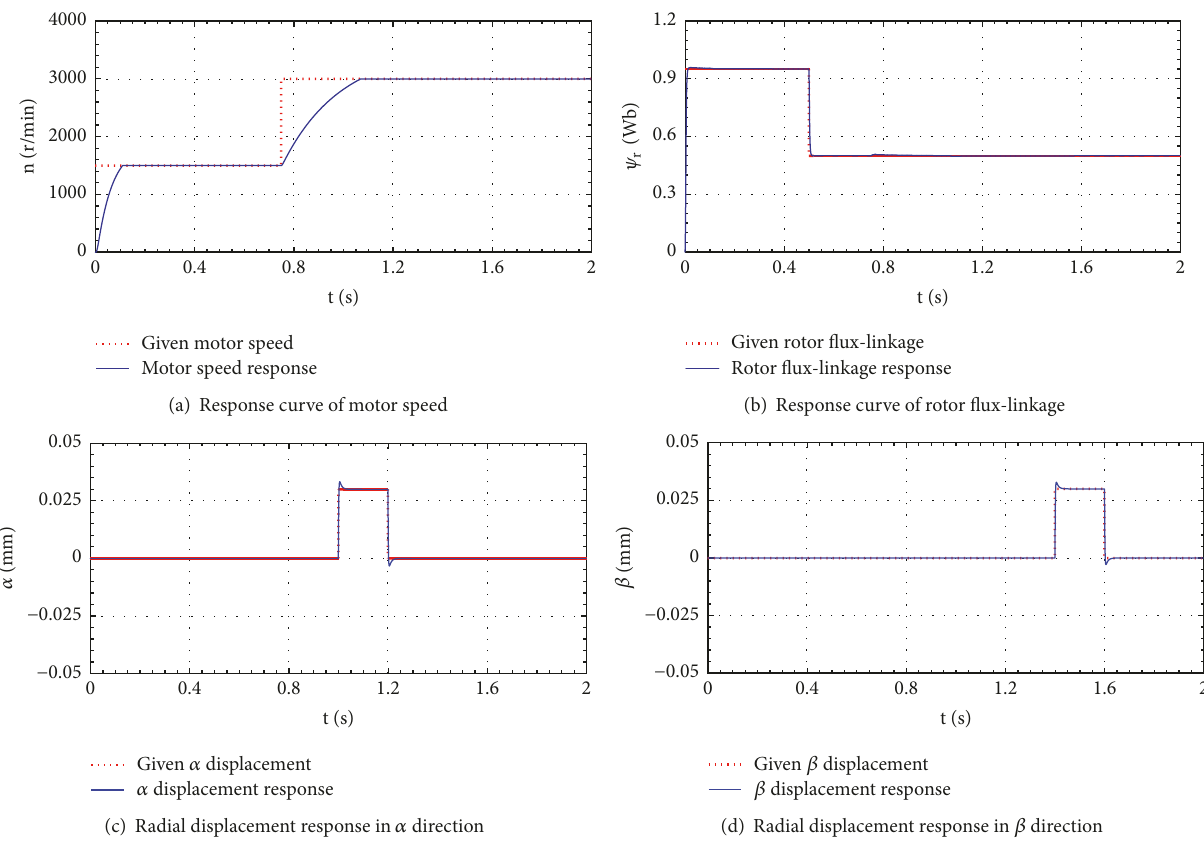
Figure 5: Response curves of decoupling control